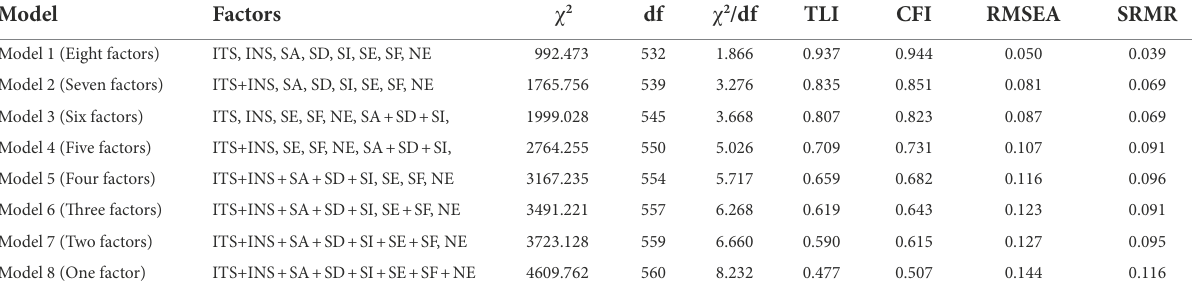
TABLE 4 Confirmatory factor analysis of variable discrimination validity.